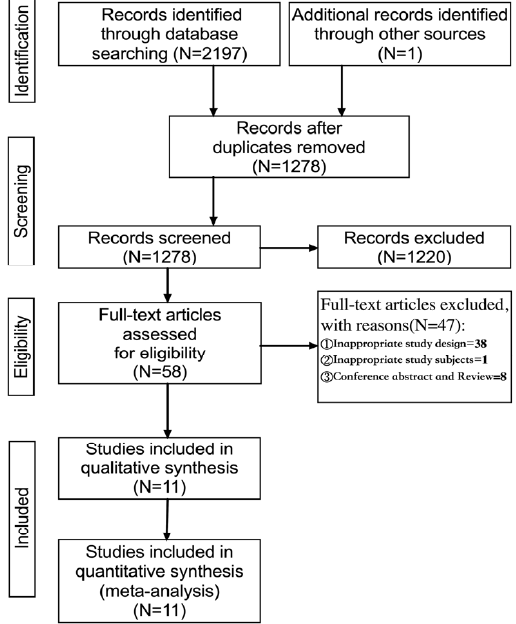
Figure 1. Flowchart of the study selection process.